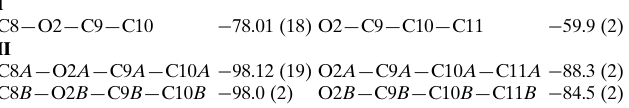
Table 3 Selected torsion angles ( (cid:3) ) for I , II A and II B